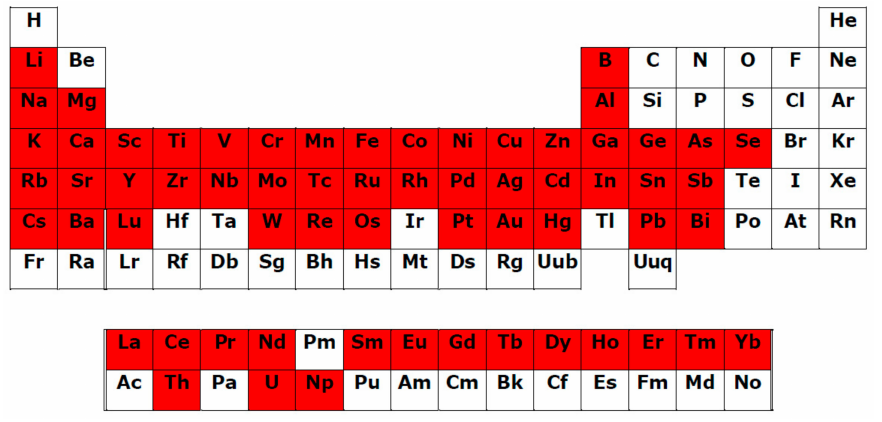
Figure 2. The elements confirmed to form phenolic ligand–Me n+ complexes (highlighted in red). Phenolic acids, as the first structural subgroup of the plant PC metabolic pathway, could be divided into hydroxybenzoic and hydroxycinnamic acids depending on the direction of their biosynthesis [186]. Among natural hydroxybenzoic acids, the complexes with Me n+ have been identified for protocatechuic acid 1, vanillic acid 2, gallic acid 3,